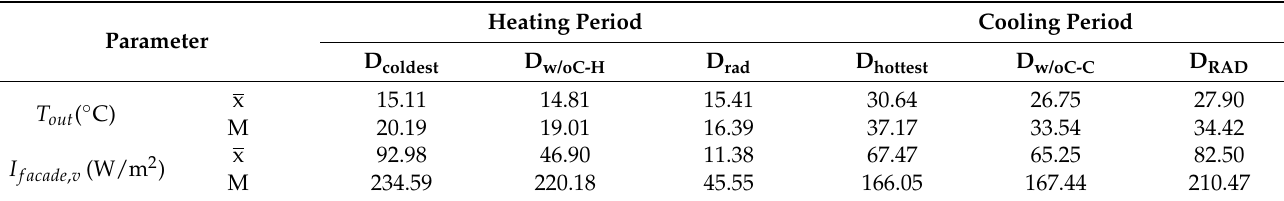
Table 4. Average, x, and maximum, M, measured values of the outdoor air temperature, T out , and of the outdoor global solar radiation measured at the reference office façade on the vertical plane, I facade , v , during the sun hours period of the heating and cooling periods’ representative days (heating period: D coldest , D w/oC-H and D rad ; cooling period: D hottest , D w/oC-C and D RAD